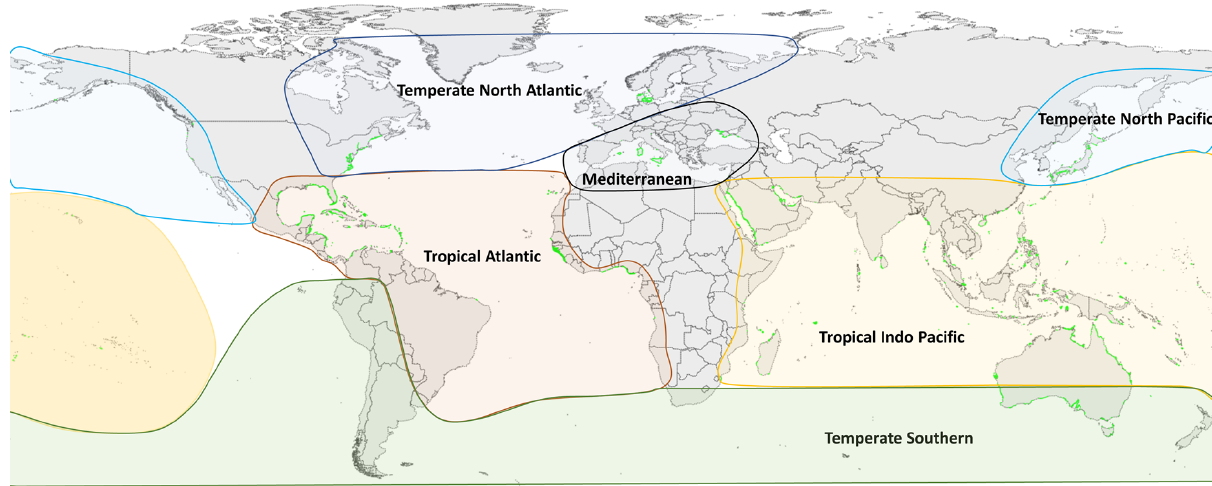
Figure 1. Global distribution of seagrass meadows (green) overlaid within six seagrass bioregions. Seagrass distribution data sourced from UNEP-WCMC and Short (2017). Seagrass bioregions adapted from Short et al.